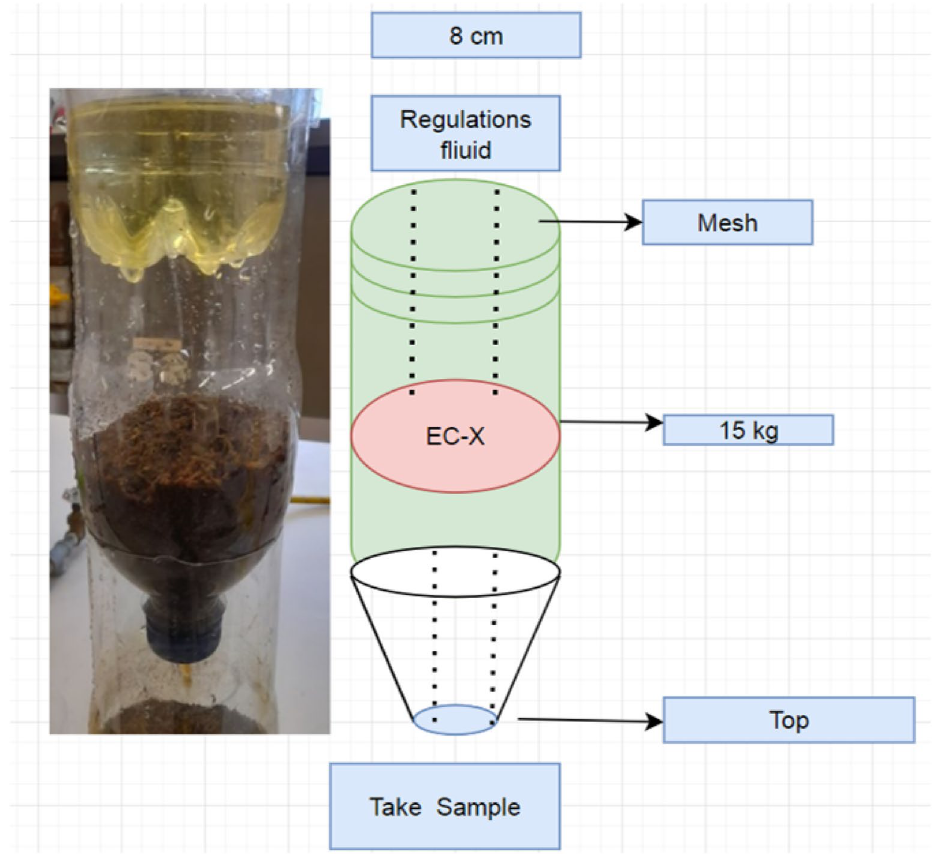
Figure 3. Prototype.